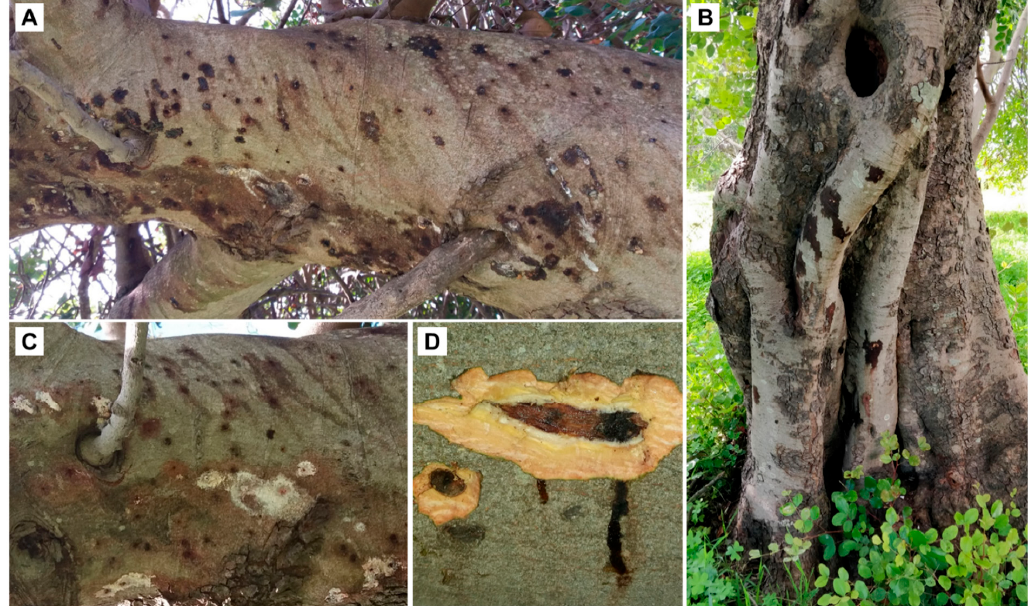
Figure 1 . Xylosandrus compactus infestation on Carob tree. Heavily infested large (diameter > 30 cm) branch ( A ); trunk of a secular Carob tree (diameter at the level of first entry hole from the ground =